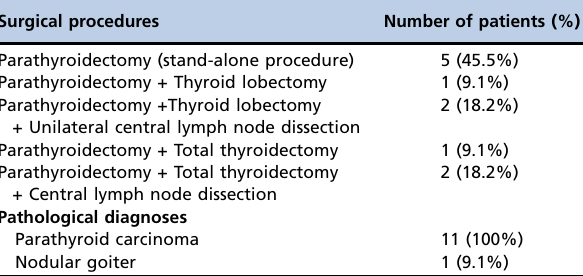
Table 2 - Surgical procedures and pathological diagnoses. Surgical procedures Number of patients